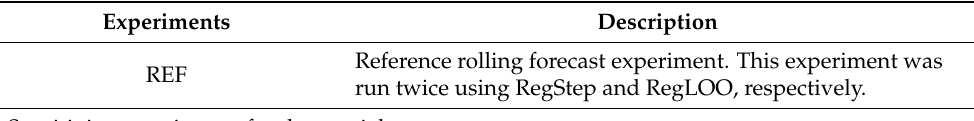
Table 2. List of all the forecast